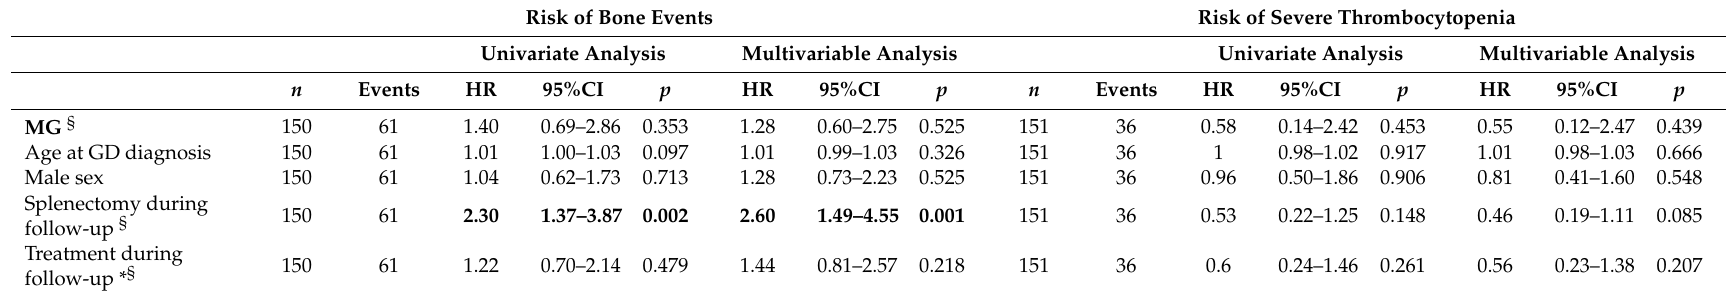
Table 4. Risk of bone events and severe thrombocytopenia with